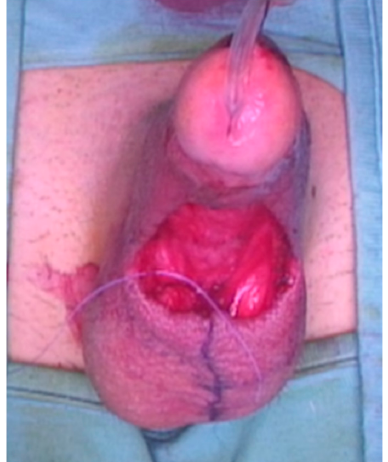
Figure 5. The subfascial scrotal tunnel was created and the penis was scrotalized.